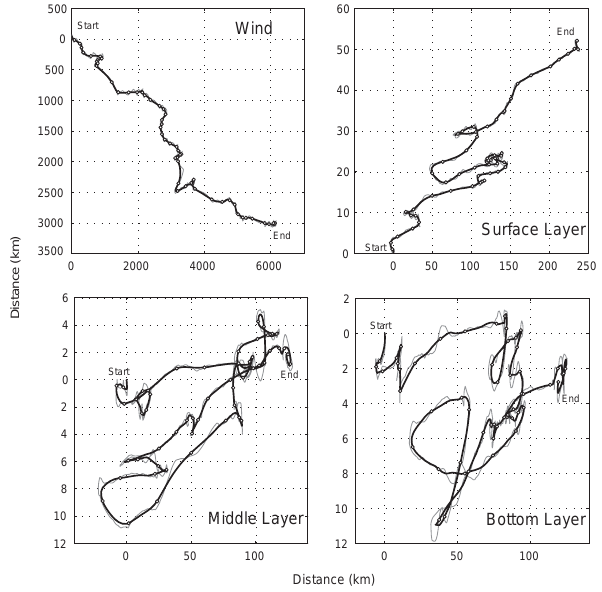
Fig. 6. Progressive vector diagram (PVD) of current and wind components from records obtained at 10min intervals and hourly filtered data sets over 57 days measurement period (4 August– 28 September). Horizontal and vertical axes are alongshore/cross- shore coordinates and each of circles on the graphs represent one day.